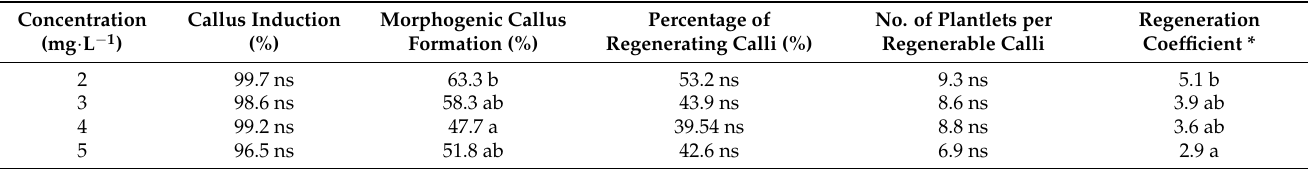
Table 1. The effect of 2.4-D concentrations on morphogenic callus production and plant regeneration in immature embryo-derived cultures of Triticum urartu , spring accession PI428197.